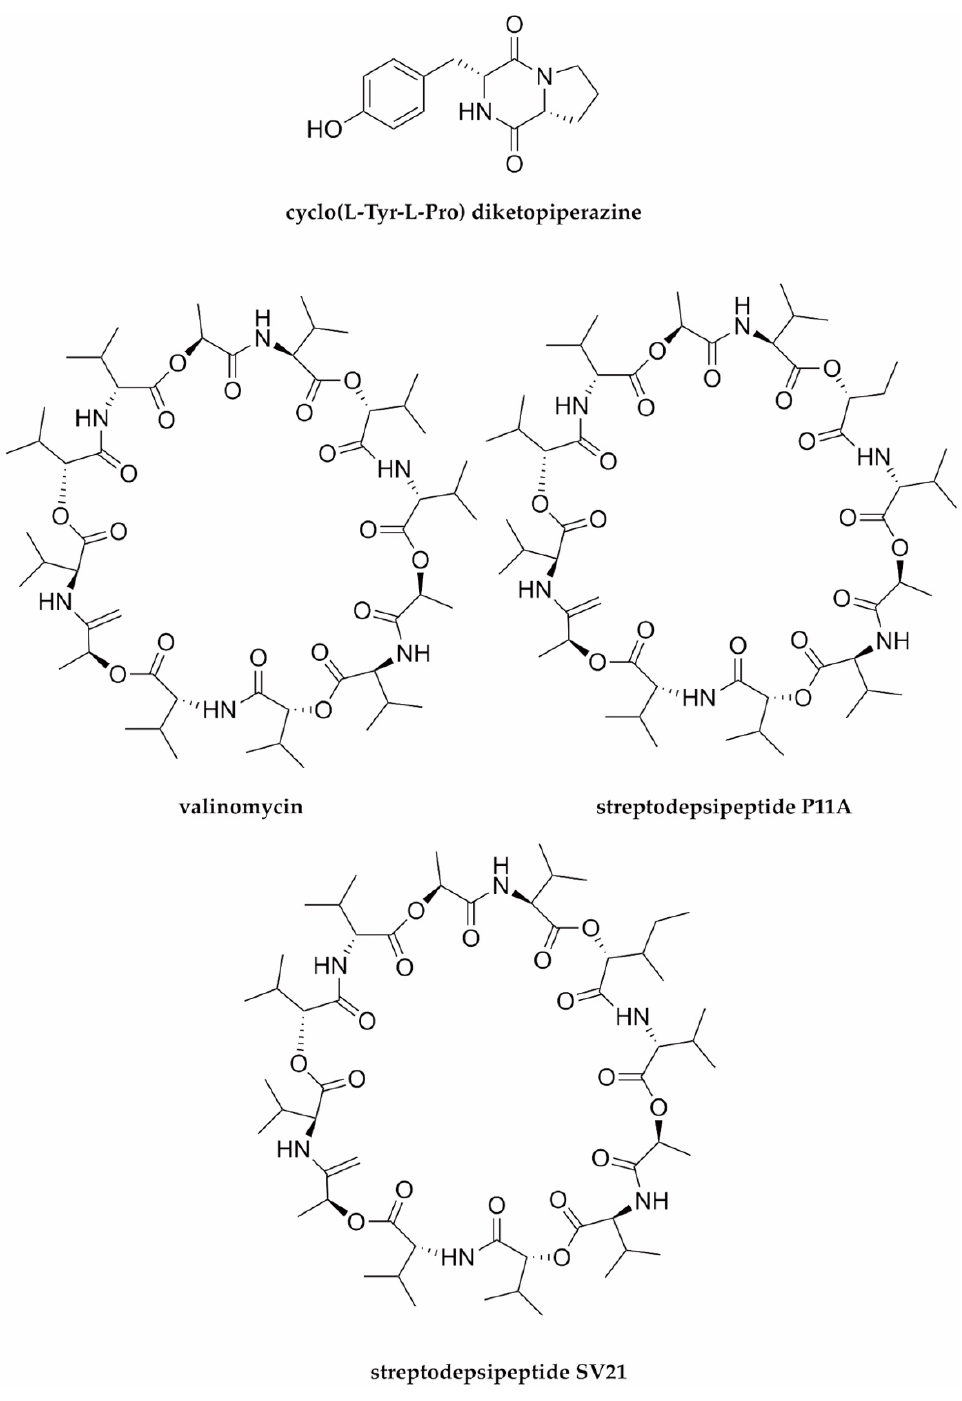
Figure 5. The chemical structures of marine-microbial-derived peptides possessing anti-HCV properties.